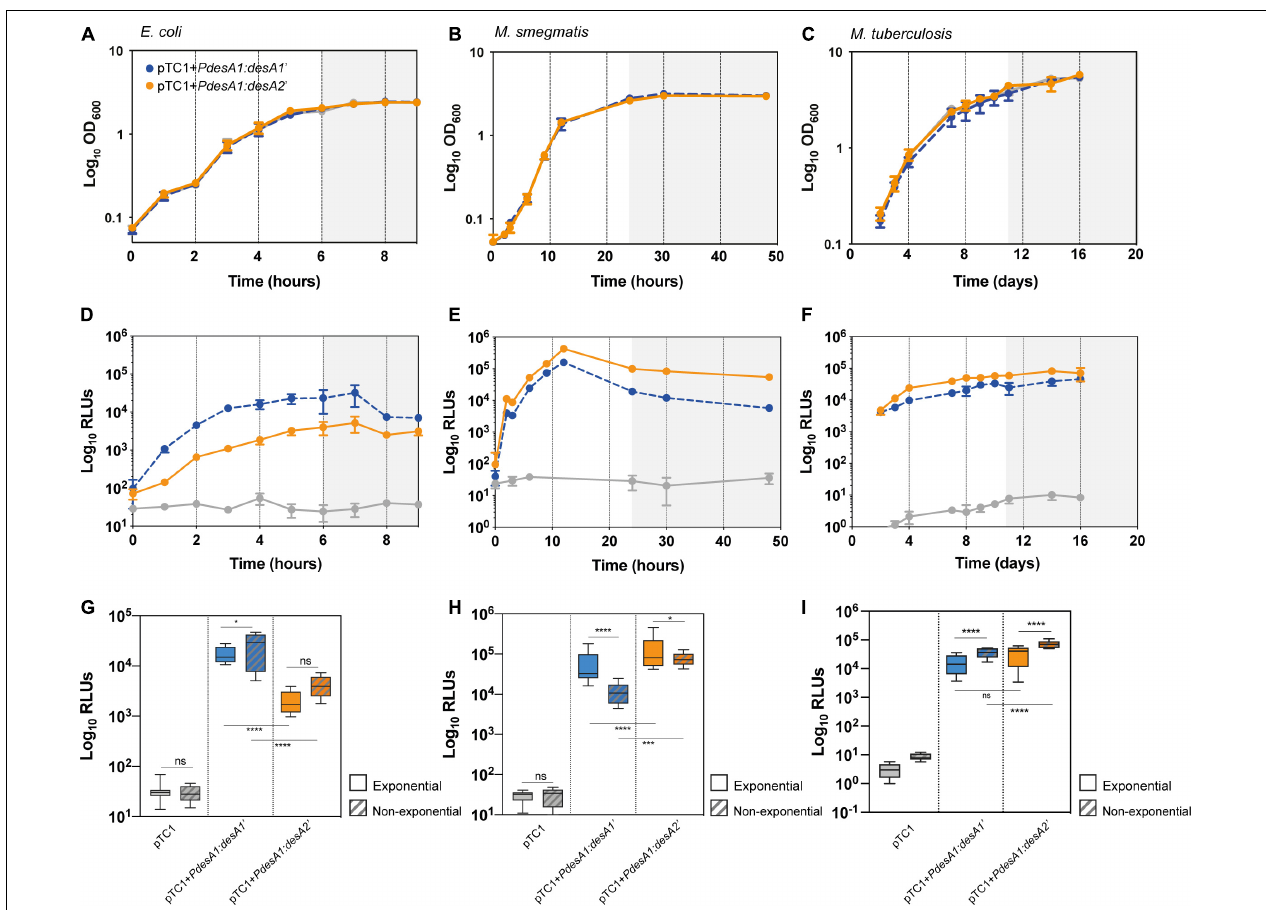
FIGURE 2 | Growth and translation kinetics of leaderless and Shine–Dalgarno reporters in three bacterial models during in vitro growth. Bacterial growth curves of E. coli (A) , M. smegmatis (B) and M. tuberculosis (C) and luminescence measured in E. coli (D) , M. smegmatis (E) and M. tuberculosis (F) transformed with pTC1 (gray), pTC1 + PdesA1 : desA1 ’ (Shine–Dalgarno, blue) and pTC1 + PdesA1 : desA2’ (leaderless, orange). The vectors are replicative in E. coli and integrative in mycobacteria. Cultures were inoculated to an initial OD ∼ 0.1 and growth (expressed as OD 600 ) and luminescence (expressed as relative light units, RLUs) were measured over 9 h for E. coli (A,D) , 48 h for M. smegmatis (B,E) and 16 days for M. tuberculosis (C,F) . Gray background within panels (A–F) indicates non-exponential growth. For each timepoint and reporter at least three independent transformants were analyzed and each experiment was performed in triplicate. The mean value and standard deviation are presented. Luminescence levels during exponential growth (clear boxes) and non-exponential growth (patterned boxes) in E. coli (G) , M. smegmatis (H), and M. tuberculosis (I) transformed with the indicated vectors. Box plots indicate median (horizontal line), interquartile range (box) and maximum and minimum values (whiskers). For E. coli (G) , exponential growth was considered for time points from 2 to 5 h and non-exponential growth (stationary growth) from 6 to 9 h (highlighted with gray background in A,D ). For M. smegmatis (H) , the exponential phase of growth was defined for time points from 6 to 12 h and non-exponential growth (stationary) for time points 24–48 h (highlighted with gray background in B,E ). For M. tuberculosis (I) , exponential growth phase was considered for time points 2–10 days and non-exponential growth from 11 days (highlighted with gray background in C,F). Means were compared using one-way ANOVA. * p < 0.05, *** p < 0.001, **** p < 0.0001, ns, non-significant.